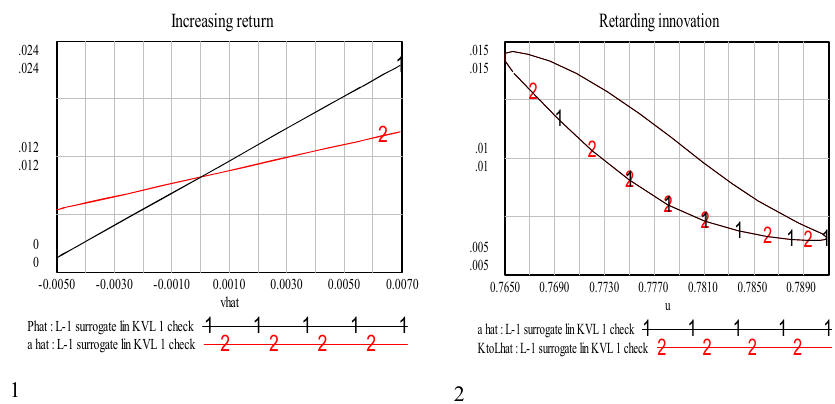
Fig. 8 The growth cycle with increasing returns and technological progress retarded by gains in unit value of labour power in L-1, years 10–17.5; panel 1—scatter graph for growth rate of employment ratio vs growth rate of net output (1) and growth rate of output per worker (2); panel 2—scatter graph for relative wage u vs the growth rate of output per worker (1) and growth rate of capital intensity